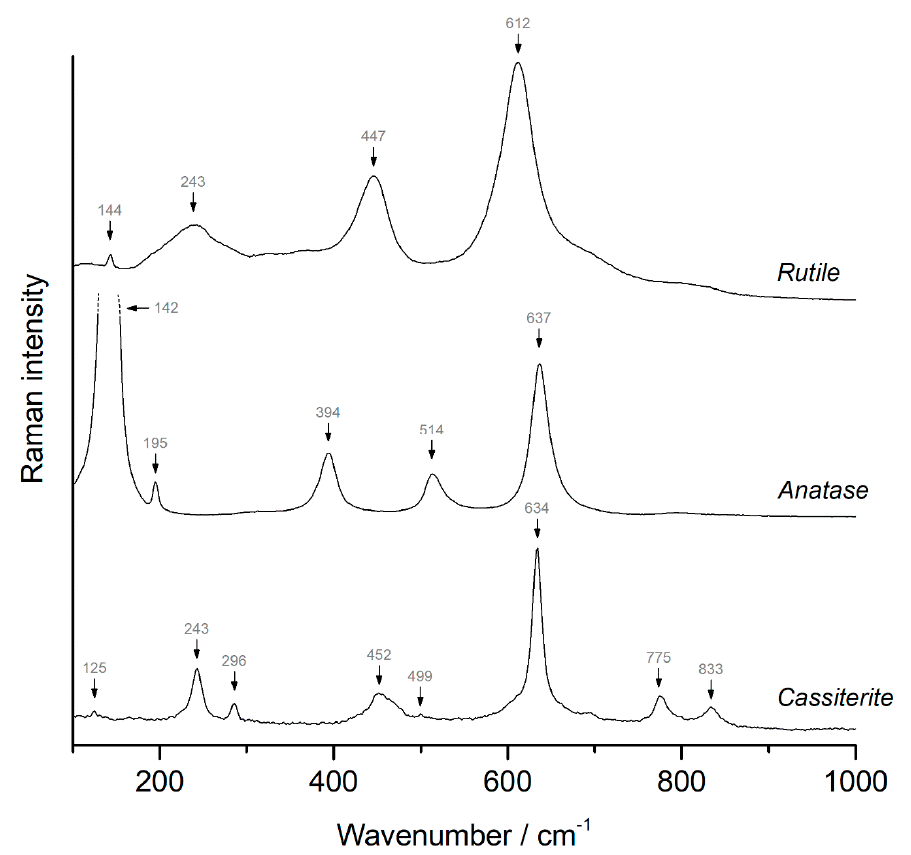
Figure 4. The Raman spectra of rutile, anatase and cassiterite.